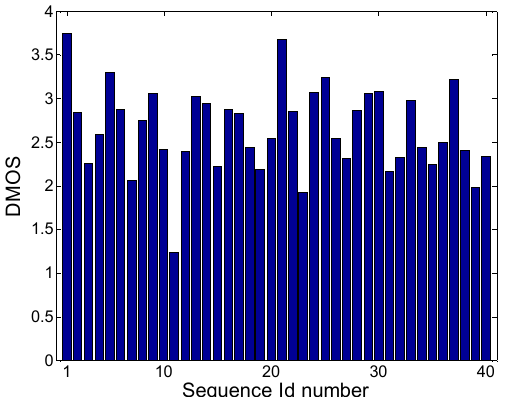
Figure 2. DMOS scores on LIVE mobile database frames with freezing degradation only.